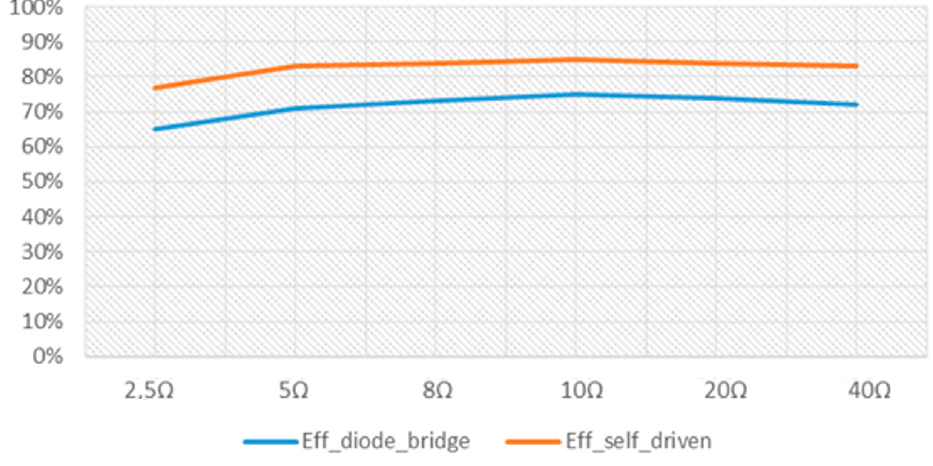
Figure 32. System efficiency vs. load variation.